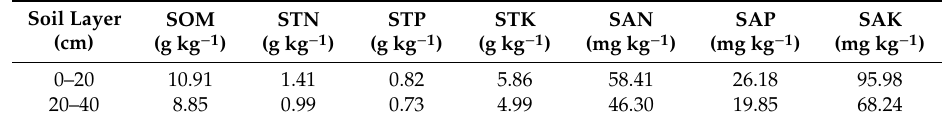
Figure 1. Mean temperature and rainfall during the growing seasons in 2015 and 2016. Table 1. Soil chemical properties of the top 40 cm in the experimental fields at the Institute of Water Saving Agriculture in Semi-Arid Regions of China in Northwest A&F University, Yangling, Shannxi Province, China, in 2015 and 2016.